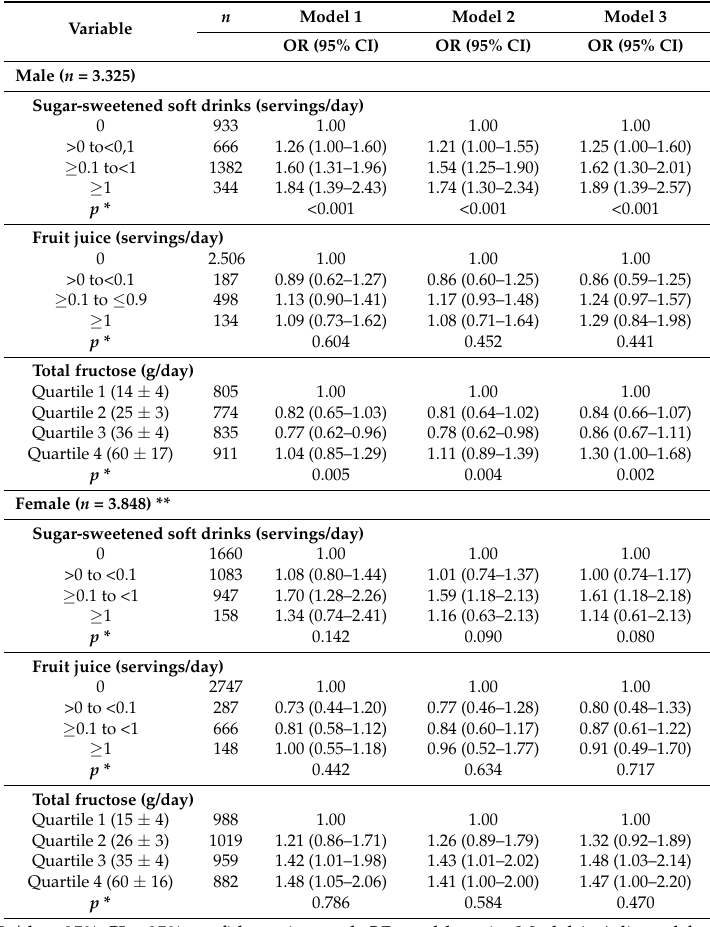
Table 3. Multivariate-adjusted ORs (95% CIs) of hyperuricemia according to categories of intake of sugar-sweetened soft drink, fruit juice, and dietary fructose. ELSA-Brasil, 2008–2010. n Model 1 Model Variable